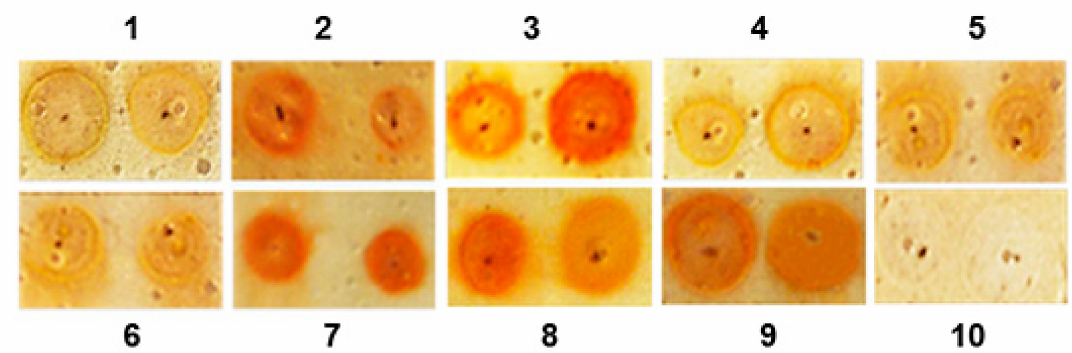
Figure 2. Orcinol–sulphuric acid test applied on to a silica-gel plate of di ff erent fractions isolated from mucus of the garden snail C. aspersum . The spots on position ( 1 ) fraction with Mw < 1 kDa; position ( 2 ) fraction with Mw < 3 kDa; position ( 3 ) fraction with Mw 3–10 kDa; position ( 4 ) fraction with Mw 5–10 kDa; position ( 5 ) fraction with Mw < 10 kDa; position ( 6 ) fraction with Mw < 20